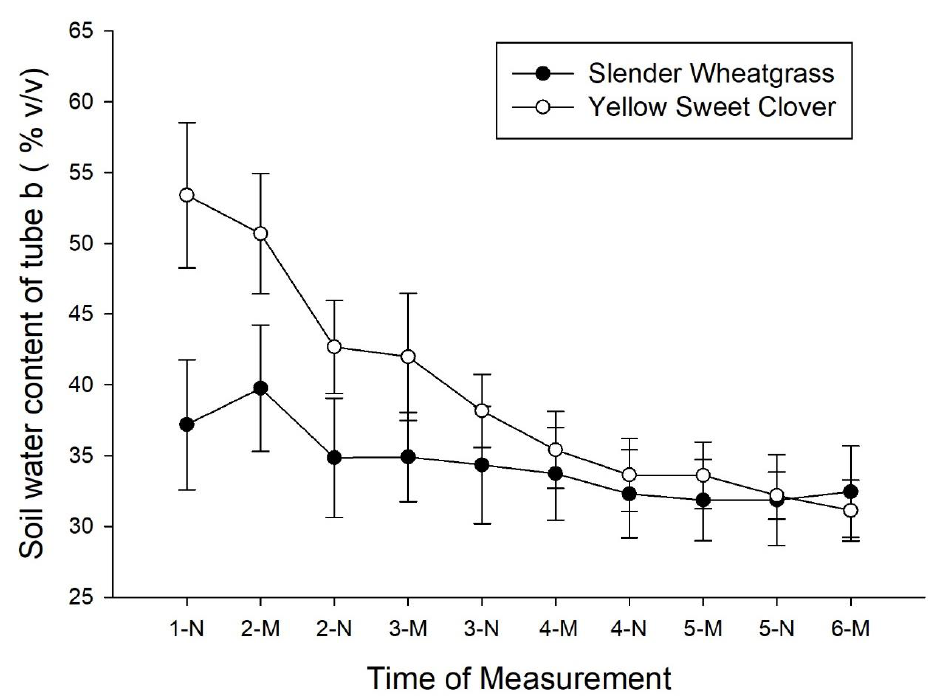
Figure 2. Diurnal patterns of soil volumetric water content in the lower PVC tube (part-b) when water was supplied only to the upper tube (part-a) in Study 1. Measurements were conducted at 6:30 in the morning (M) and at 21:30 at night (N). Means ± SE (standard error) ( n = 5) are shown. v / v means volume to volume.